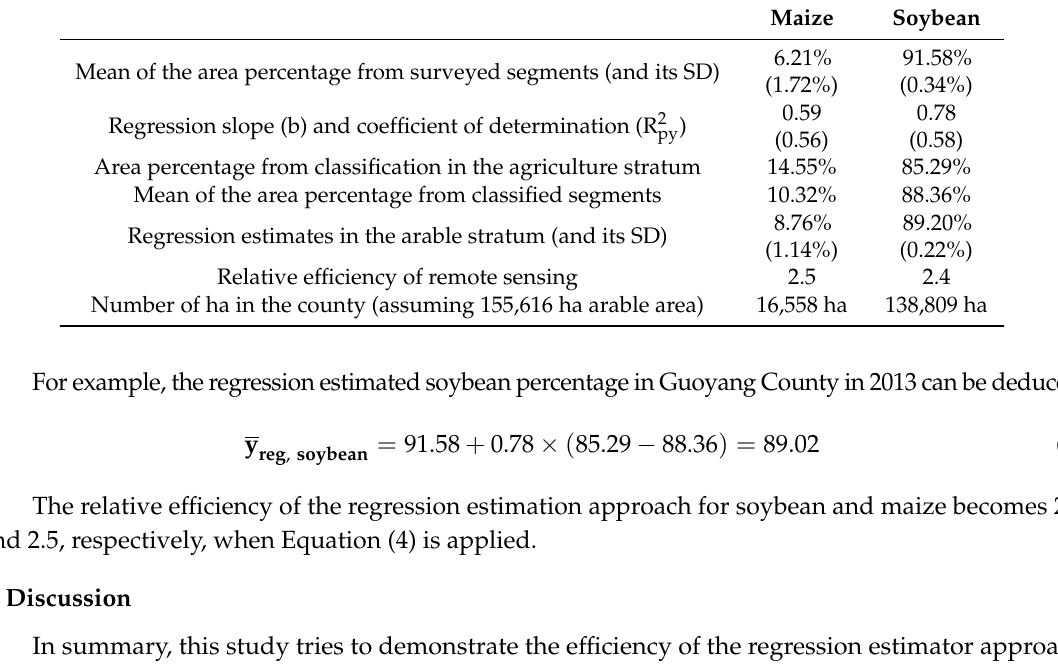
Table 3. Crop area proportions derived from a ground survey, image classification, and the regression estimator. SD = standard deviation. Mean of the area percentage from surveyed segments (and its SD) Regression slope (b) and coefficient of determination (R 2 py ) Area percentage from classification in the agriculture stratum 14.55% 85.29% Mean of the area percentage from classified segments 10.32% 88.36% Regression estimates in the arable stratum (and its SD) Relative efficiency of remote sensing 2.5 2.4 Number of ha in the county (assuming 155,616 ha arable area) 16,558 ha 138,809